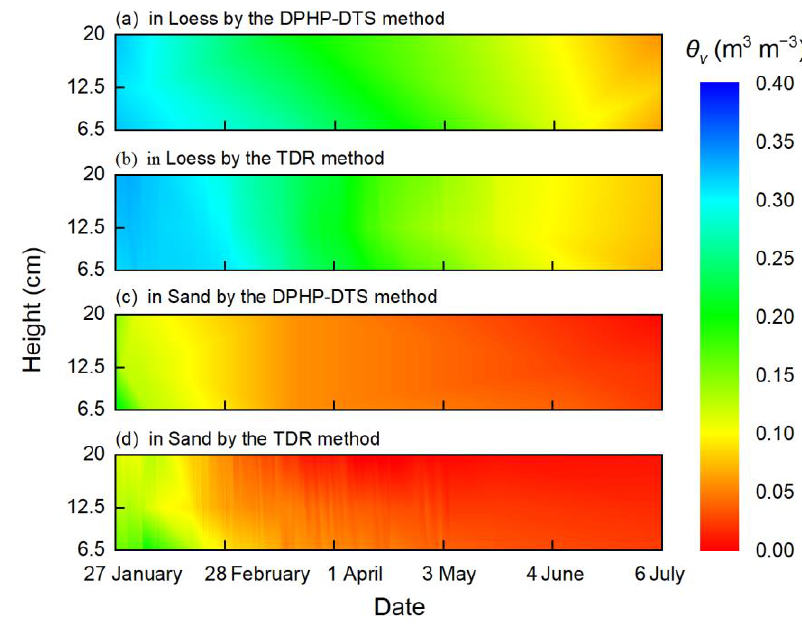
Figure 9. Temporal and spatial distribution of θ v during evaporation from 27 January to 6 July: ( a ) θ v in loess measured by the DPHP-DTS method, ( b ) θ v in loess measured by the TDR method, ( c ) θ v in the sand measured by the DPHP-DTS method, and ( d ) θ v in sand measured by the TDR method. The evaporation rates of the sand and loess are different. At the beginning of the evaporation process, the evaporation rate of the sand is faster than that of the loess. From 27 January to 28 February, the evaporation rate of the loess is 0.39 mm d − 1 , and the evaporation rate of the sand is 0.55 mm d − 1 . However, as the evaporation process continues, the evaporation rate of the loess is faster than that of the sand. From 27 January to 6